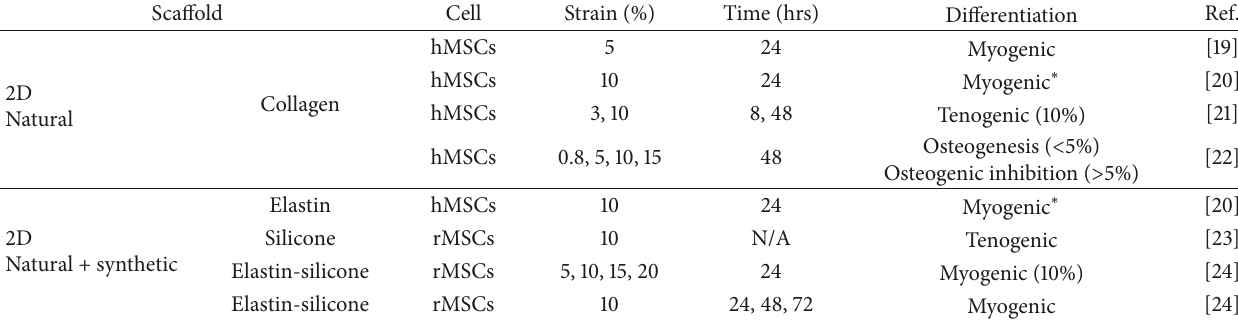
Table 2: Effect of cyclic tensile strain on MSCs seeded on 2D